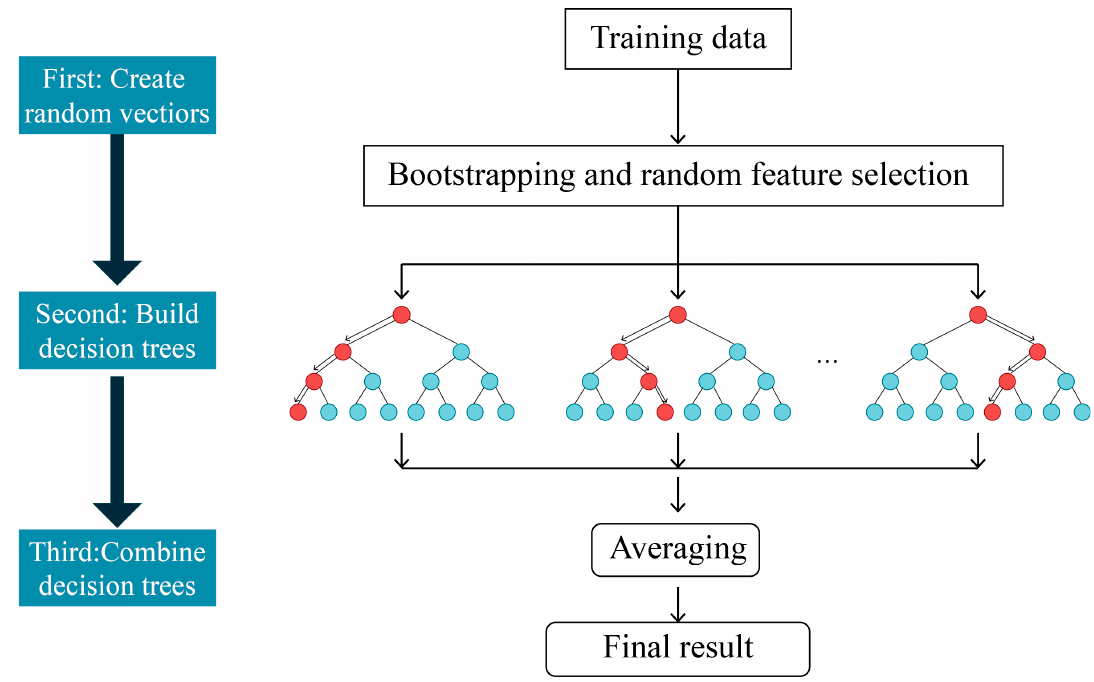
Figure 2. Working route of the random forest algorithm. Source: Cheng et al., 2020